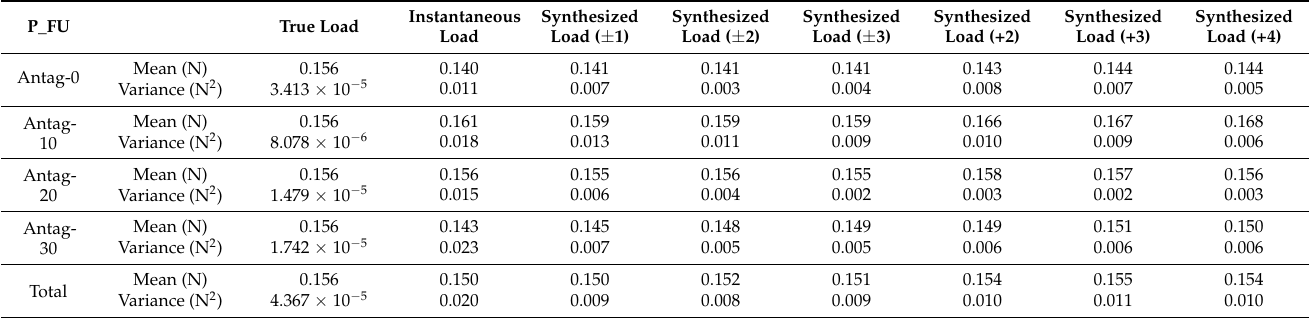
Figure 7. The test data of active load-sensing scheme with 5.0 mm endoscope from NN ( a ) 0.15 N, ( b ) 0.22 N. Table 1. The mean and variance of different exploration sequences with true load 0.15